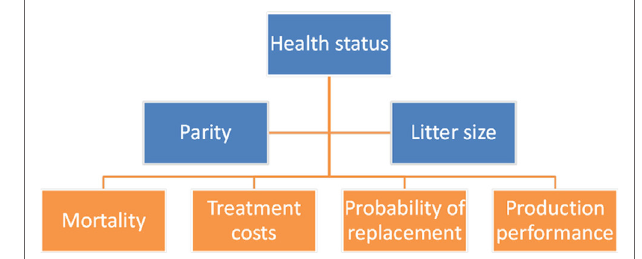
FigUre 1 | State variables (in blue) influence economic and physical performance parameters (in orange) of a sow in the dynamic programming model.